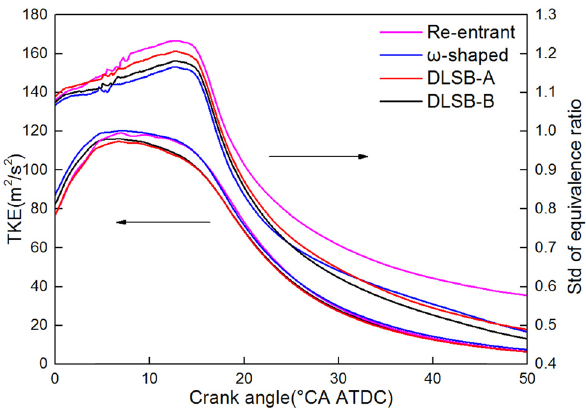
Figure 12: TKE and STD of equivalence ratio under di ff erent piston bowls.